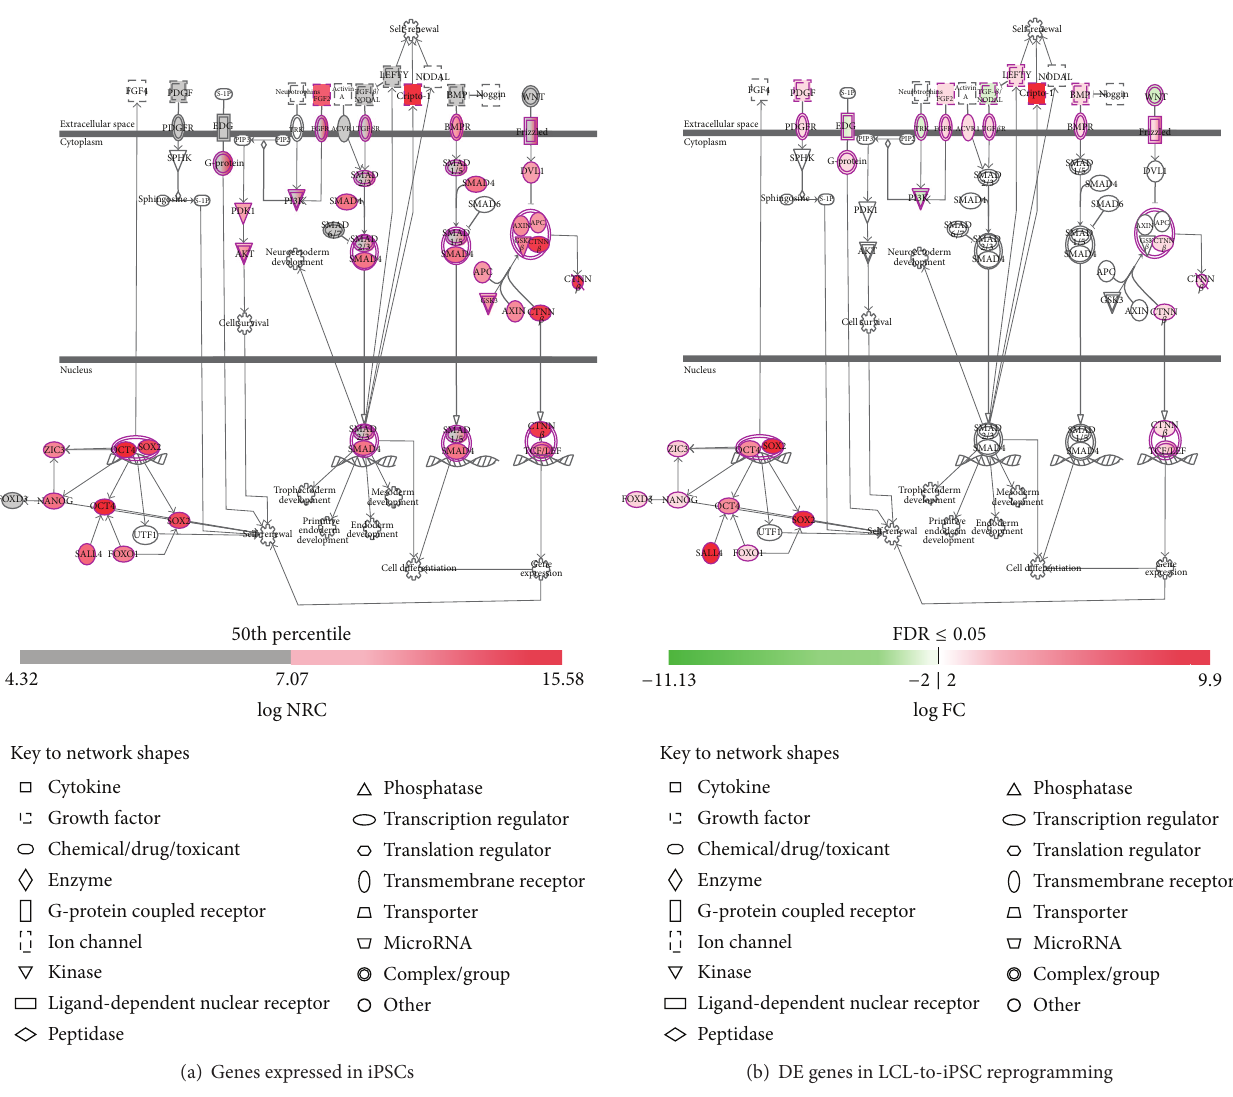
Figure 7: Diagram showing key human pluripotency pathways in ESCs/iPSCs. (a) Pathway genes expressed in reprogrammed iPSCs. (b) Differential expression of pathway genes during LCL-to-iPSC